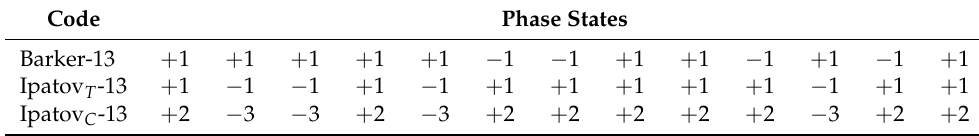
Table 2. Various length 13 BPSK